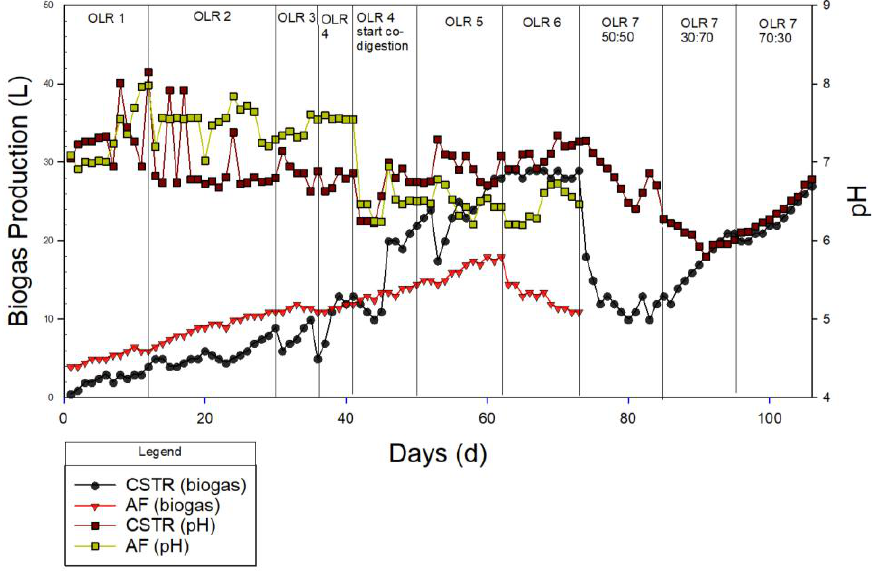
Figure 5. Biogas production and pH of continuous system.